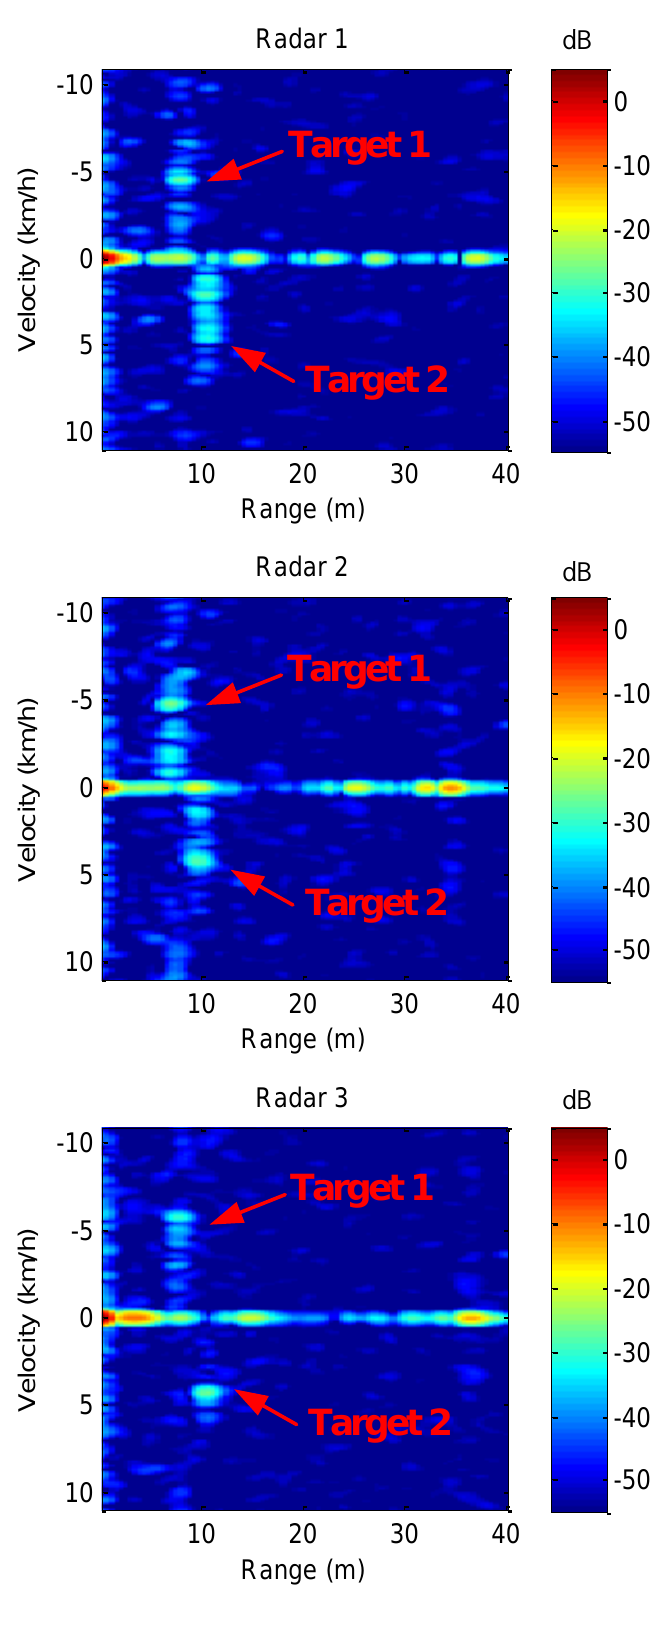
Figure 12. Range-Velocity maps of one frame of the